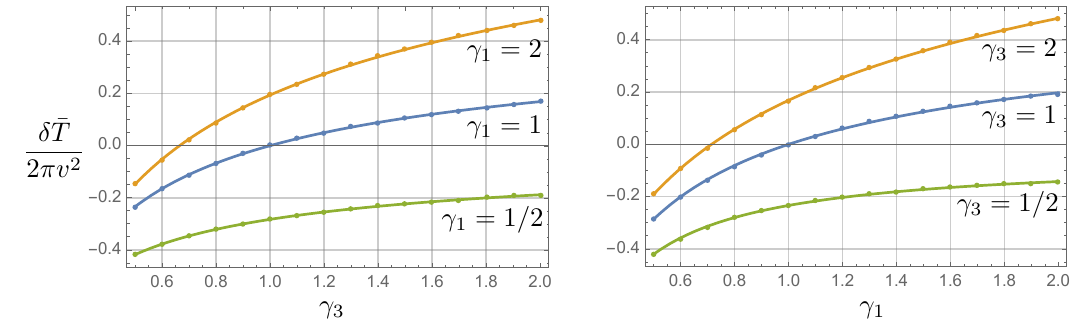
(cid:22) T= 2 (cid:25)v 2 is shown for the three di(cid:11)erent